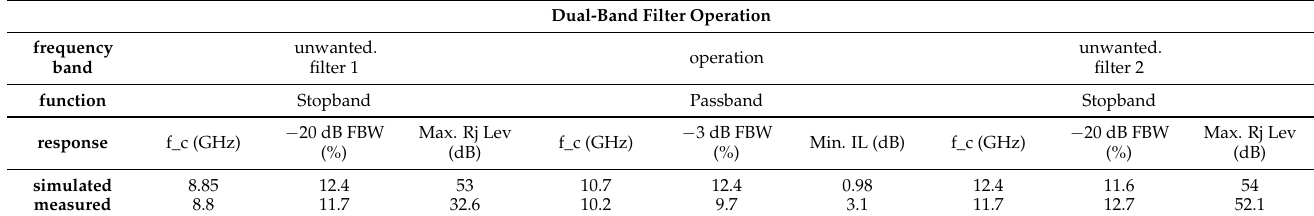
Figure 16. Measured versus simulated S parameters for the designed IM-GWG dual-band filter with geometrical parameters included in Table 1. Table 3. Simulated and measured IM-GWG EBG dual-band filter comparison